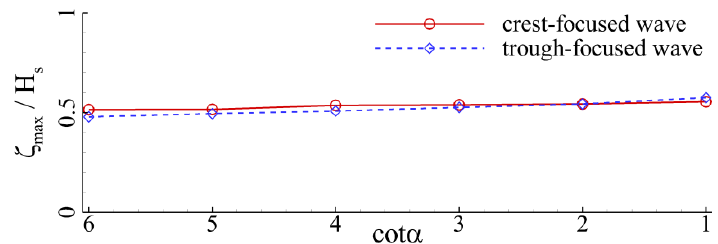
Figure 42. Maximum water elevation at the reef crest versus the forereef slope.